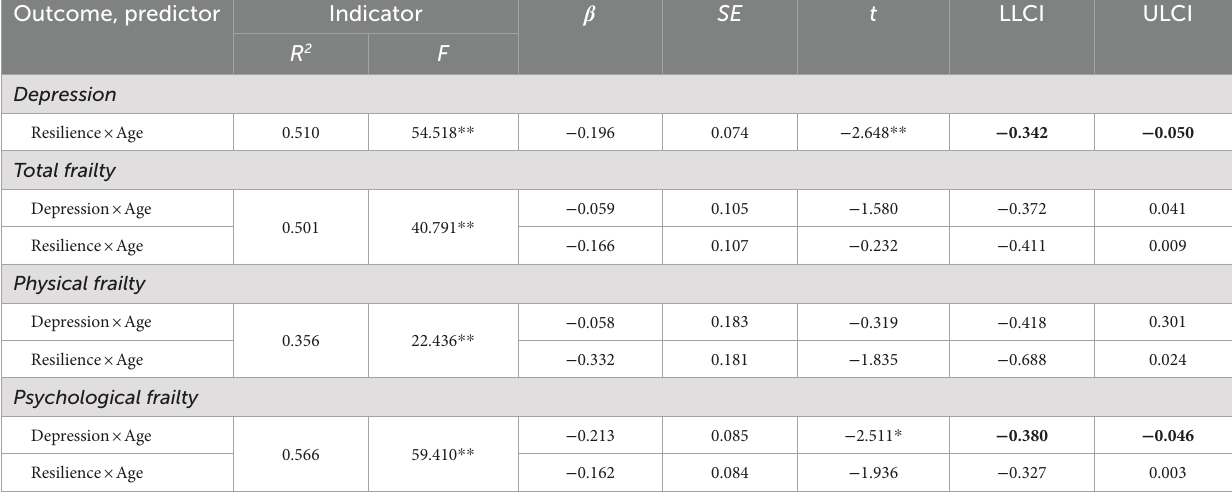
TABLE 5 Results of age as a moderator on the relation between resilience on frailty via depression. Outcome,